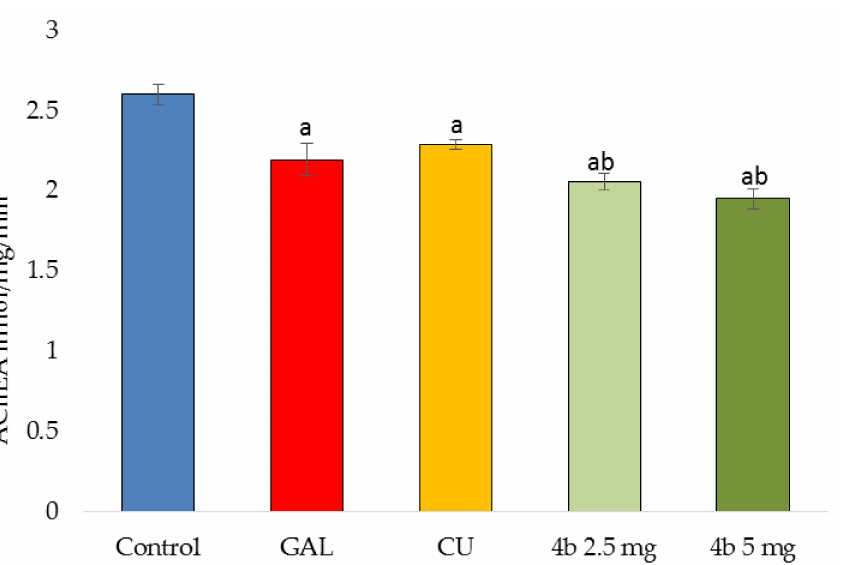
Figure 2. Acetylcholinesterase (AChE) activity measured for 10 min in brain homogenates derived from mice treated 14 days by GAL, CU, 4b in two doses (2.5 mg/kg and 5 mg/kg) or placebo (control group). a p < 0.05 vs. control b p < 0.05 vs.